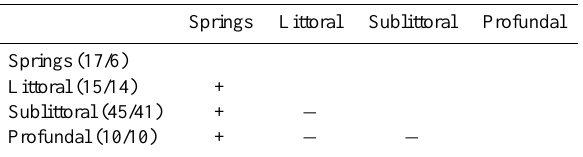
Table 2. Results of the exact test of significant pairwise genetic differences ( P level 0.05) between 87 specimens of Dina spp. from different habitats of the Ohrid watershed. Numbers in parenthesis indicate number of specimens studied/number of haplotypes found in the respective group. Springs Littoral Sublittoral Profundal Springs (17/6) Littoral (15/14) Sublittoral